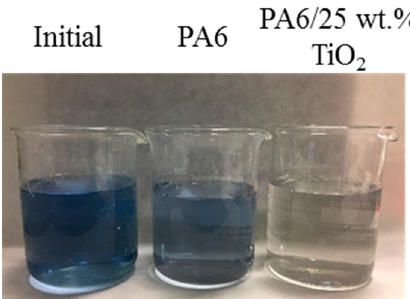
Figure 5. Images of dye solution’s colour (from left to right): initial, after 4 h of contact with PA6 nanofiber membranes under UV light and after 4 h of contact with PA6/25 wt.% TiO 2 nanoparticles nanofiber membranes under UV light.